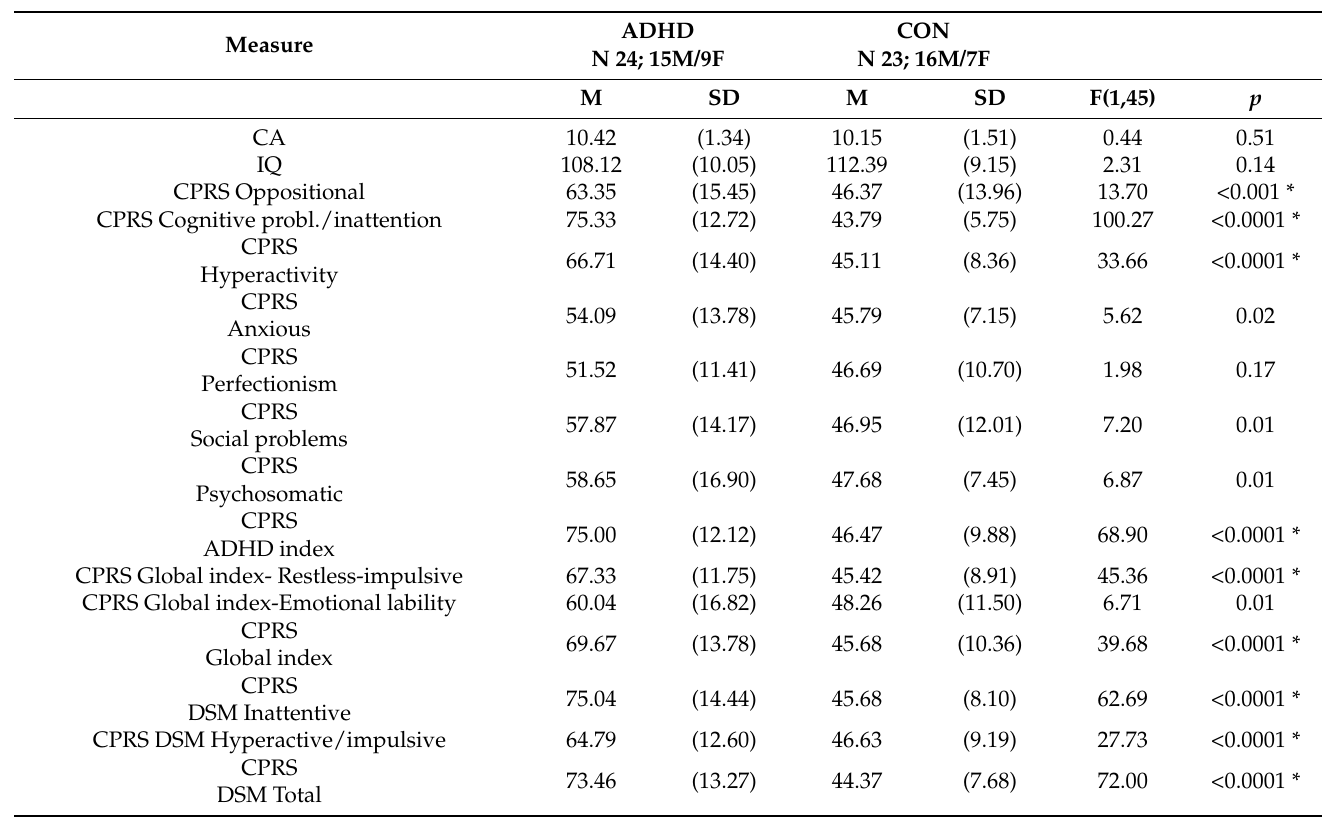
Table 1. Characteristics of